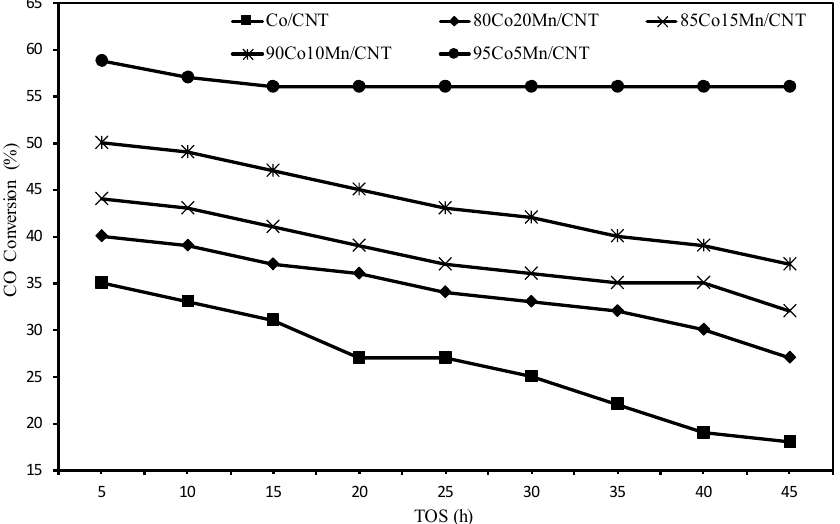
Figure 1. Time on stream (TOS) efficiency for catalysts deposited on CNT pre-treated at 240 °C, 20 atm, and H 2 /CO = 2 reaction conditions.